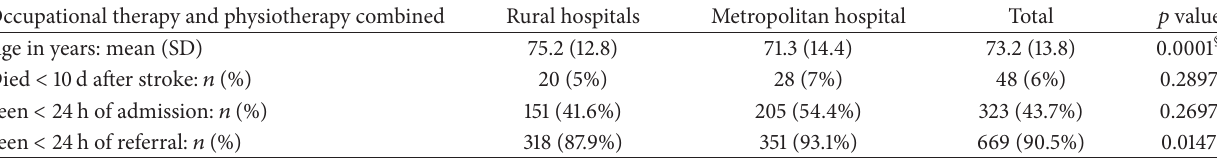
Table 2: Demographic